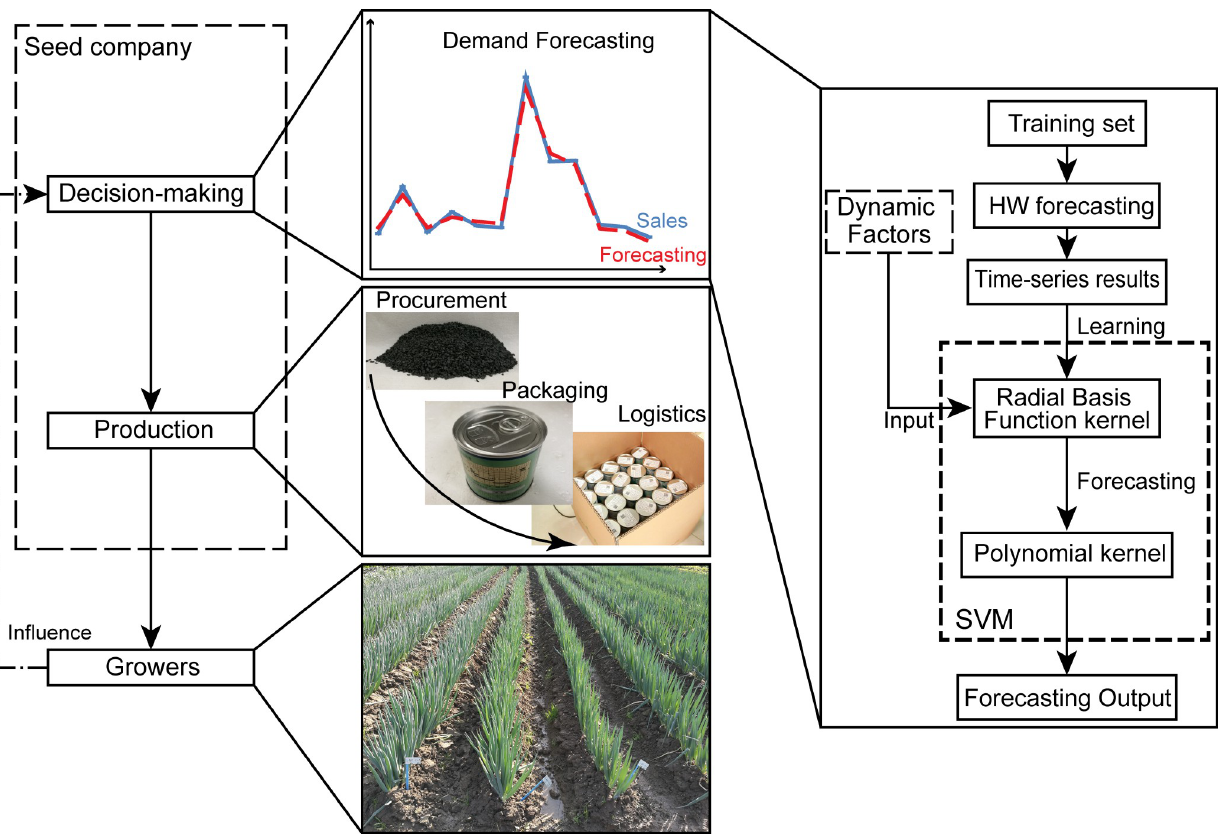
Fig 1. Spring onion seed demand forecasting methodology and its importance. The left side shows the relationships between demand forecasting and other processes. The right side shows the hybrid Holt-Winters (HW) and support vector machine (SVM) demand forecasting methodology proposed in this